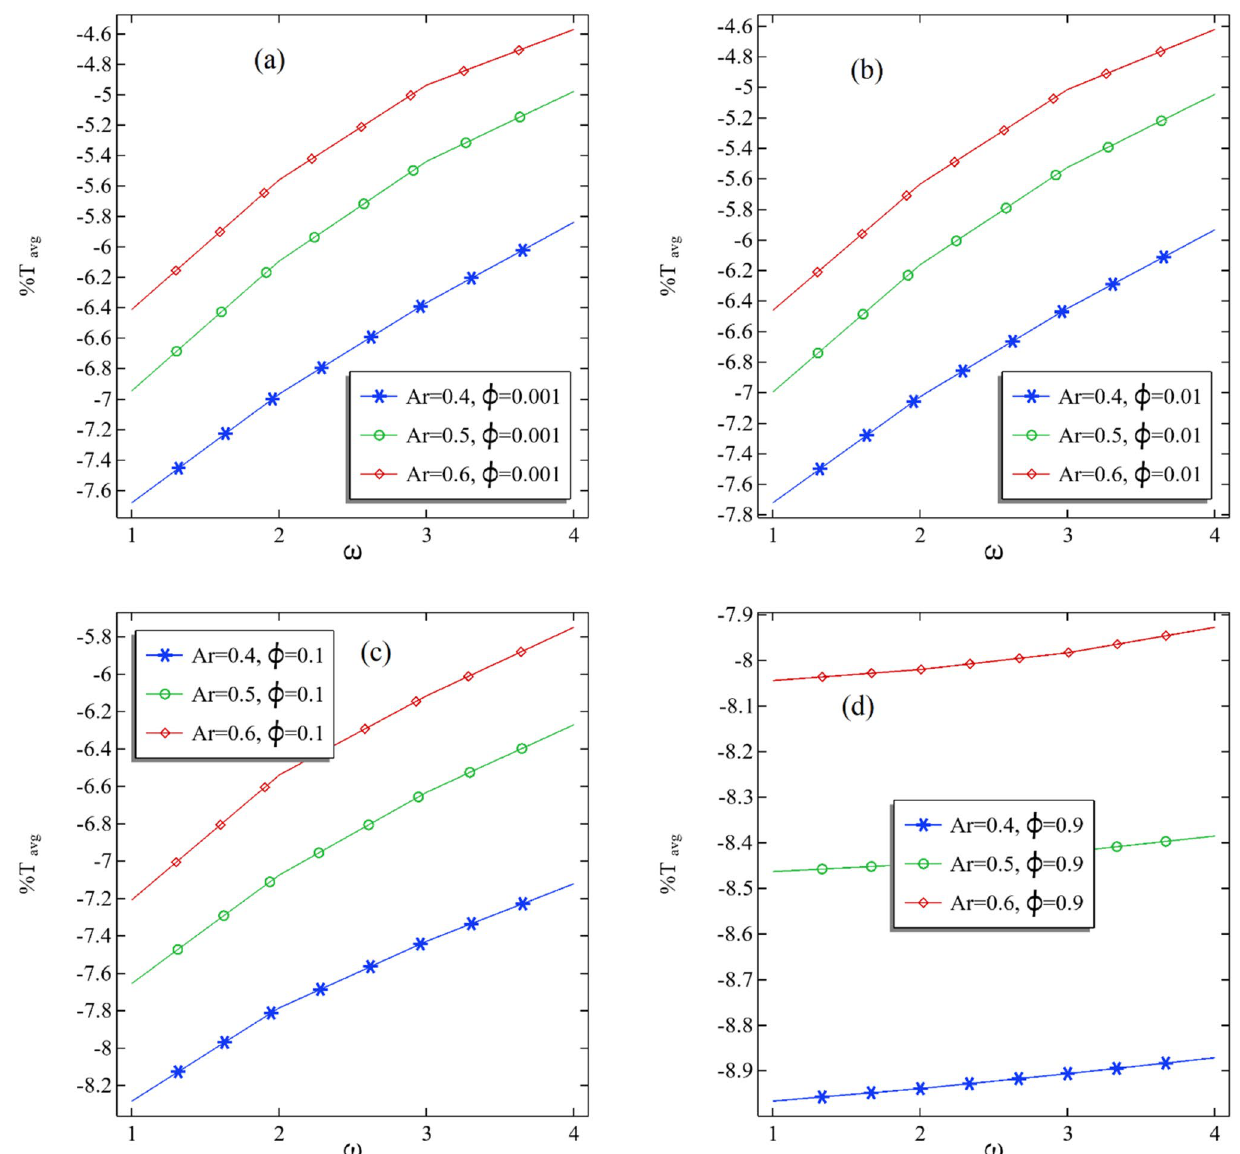
Figure 9. ( a – d ) The average percentage change %T at the middle plane of the annular with the increasing volume fraction of the